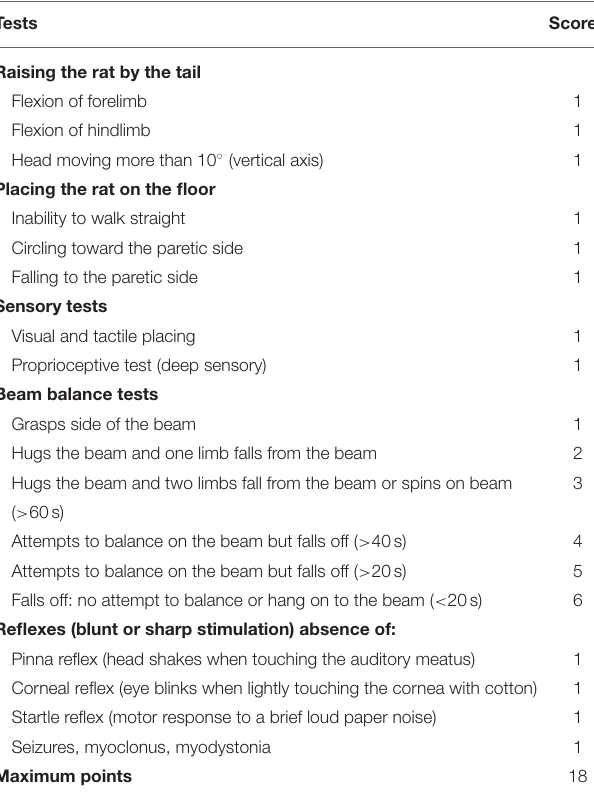
TABLE 1 | Modified neurological severity scores (mNSS) (Chen et al.,